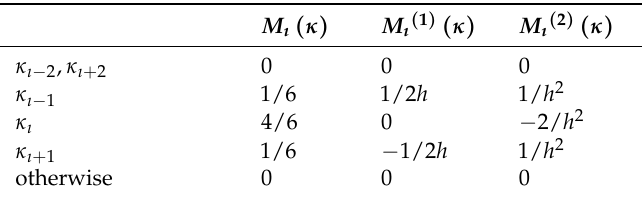
Table 1. Values of M ı ( κ ) and its